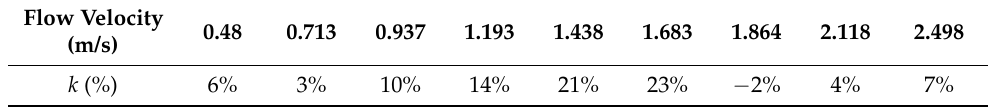
Table 3. Drag reduction rate at different flow velocities.